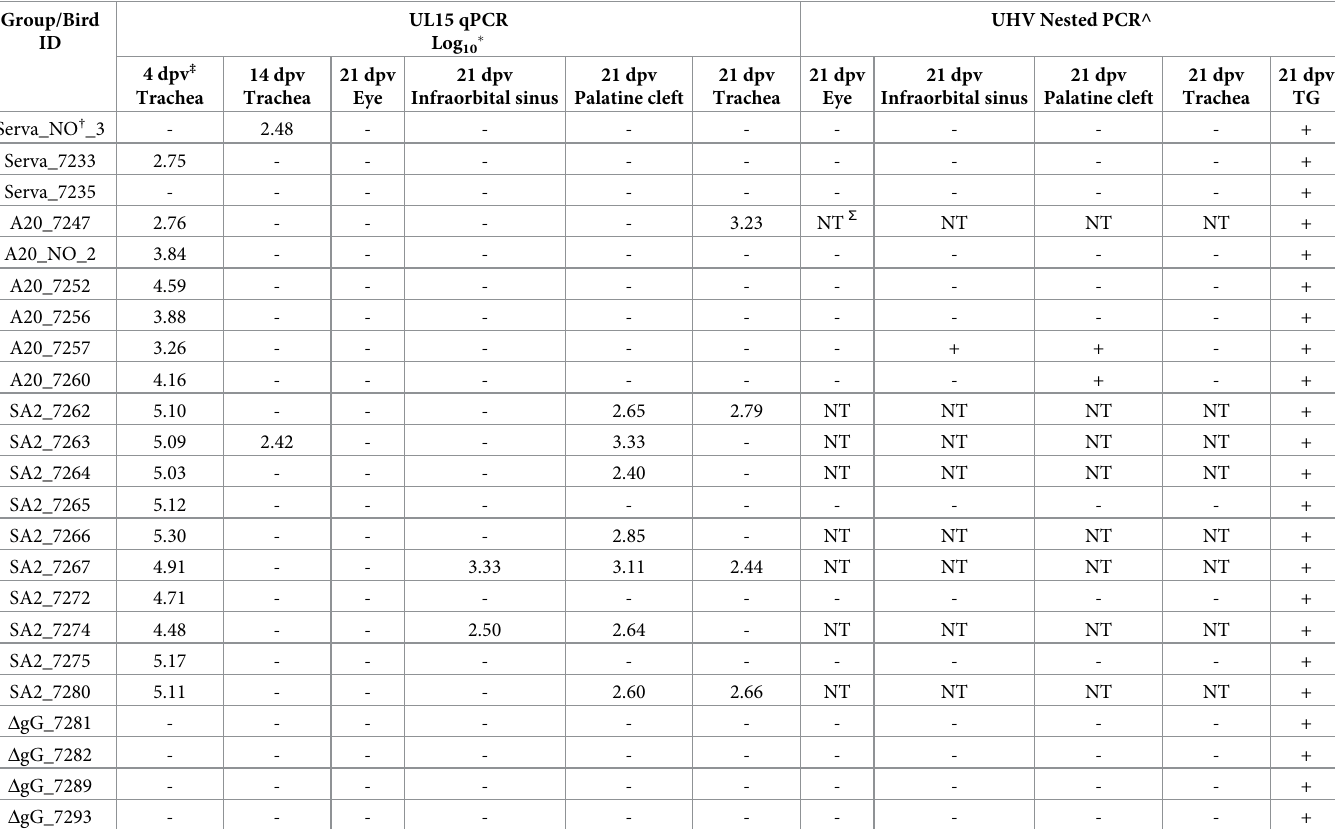
Table 2. Detection of ILTV DNA by quantitative and nested PCRs in swabs collected from the upper respiratory tract or trachea of SPF chickens after vaccination with Serva, SA2, A20 or Δ gG ILTV. Only results from birds that had detectable levels of ILTV DNA in their trigeminal ganglia are shown. Group/Bird